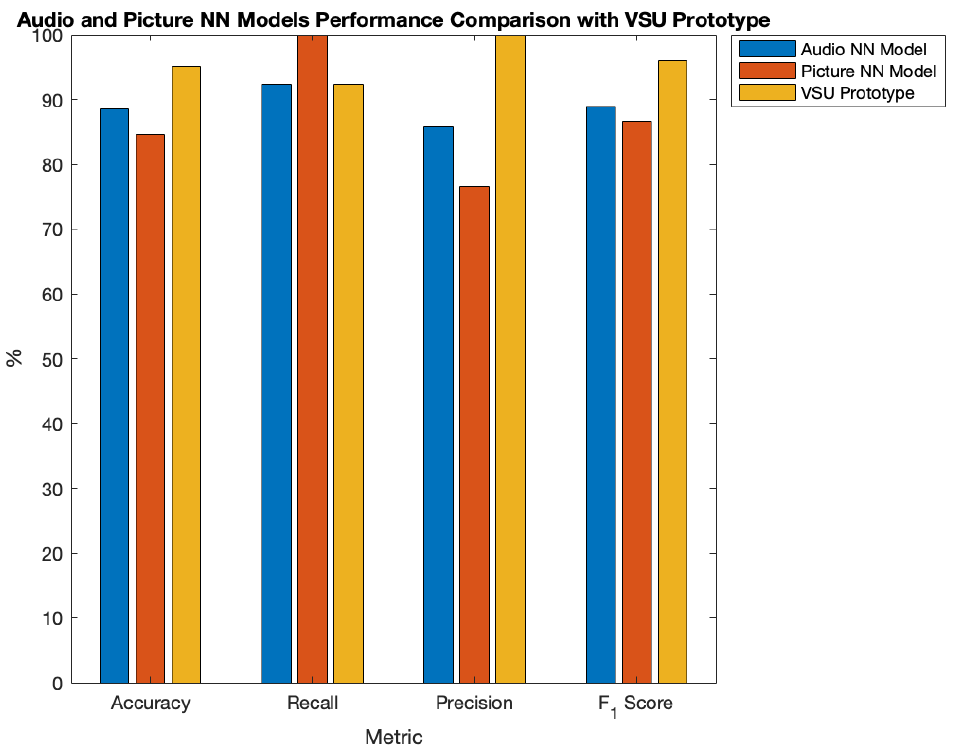
Figure 10. Performance comparison of the audio NN model, picture NN model, and VSU prototype.